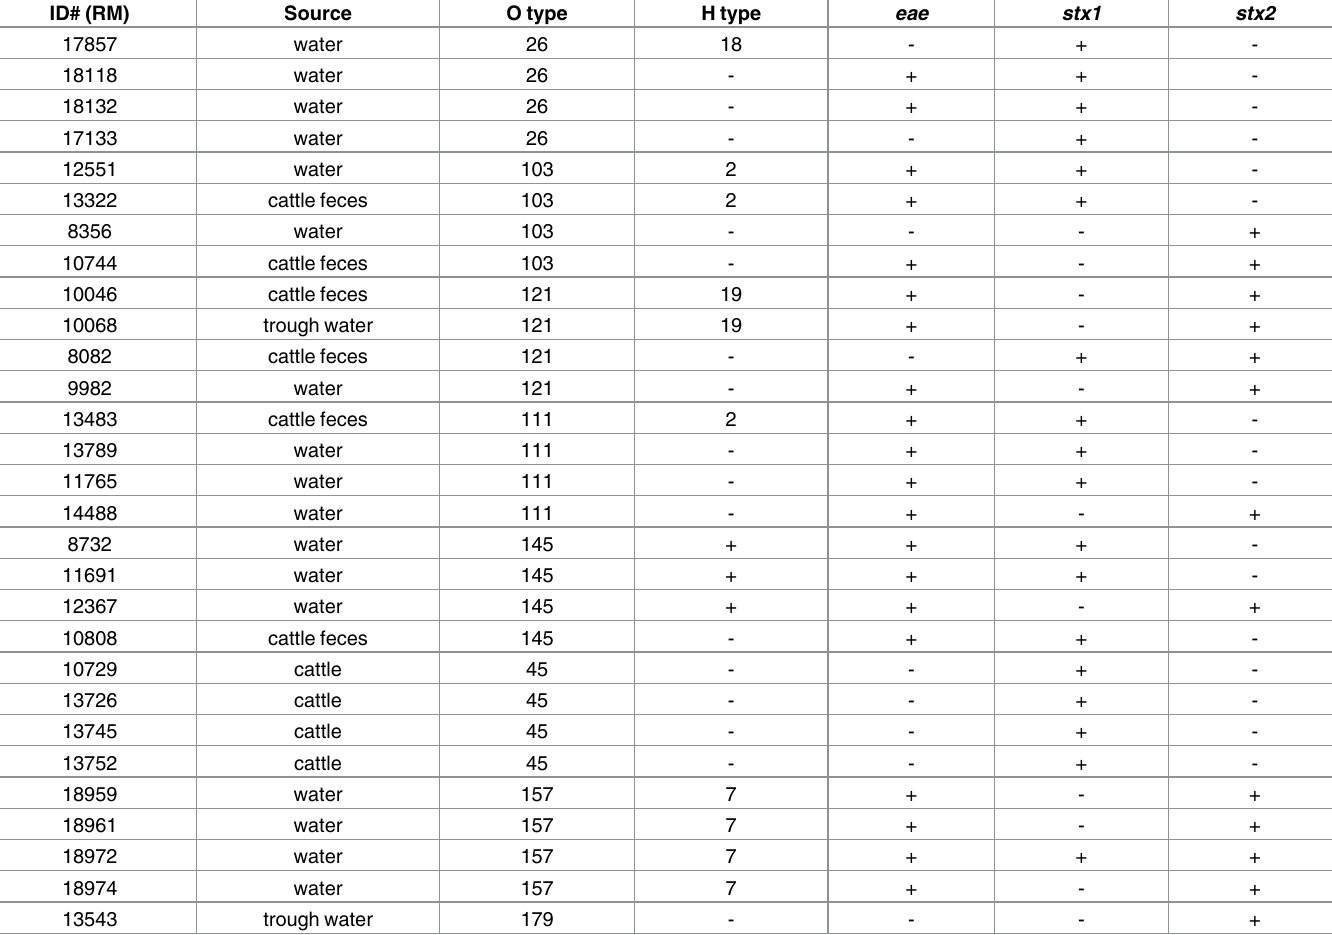
Table 1. Shiga toxin-producing E . coli (STEC) strains isolated from different sources by U.S. Department of Agriculture ARS used for free STEC- specific phage isolation. ID#